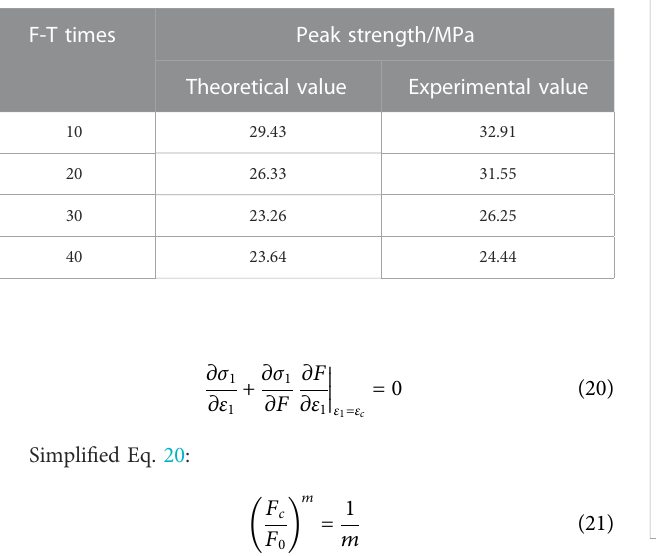
TABLE 3 Comparison between theoretical value and experimental value.